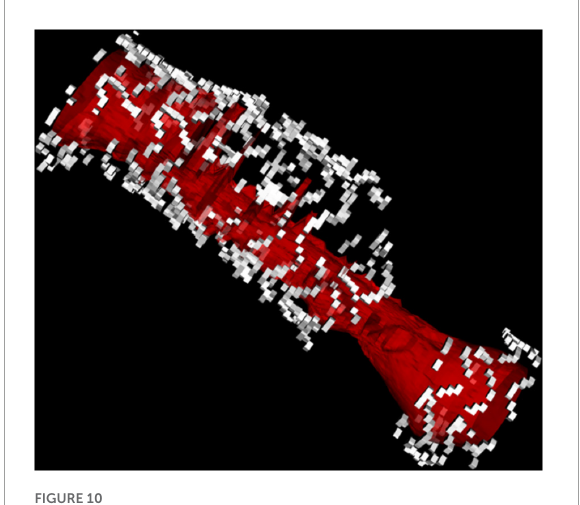
FIGURE10 3D reconstruction of a stent fracture and gap associated with ISR (the lumen is depicted in